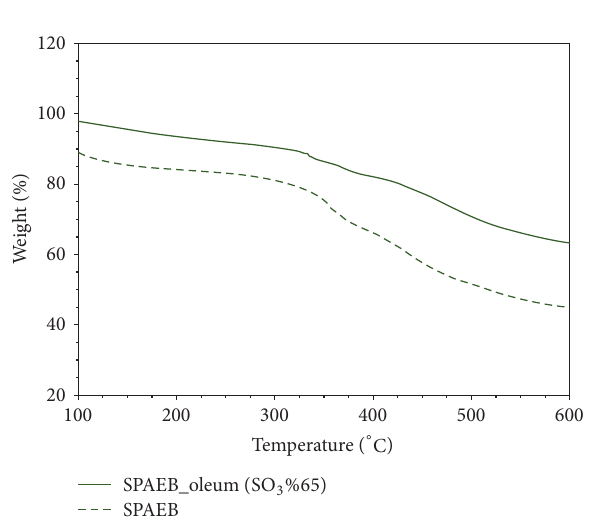
Figure 9: TGA curves of the SPAEB and SPAEB oleum (SO 3 %65) copolymers.